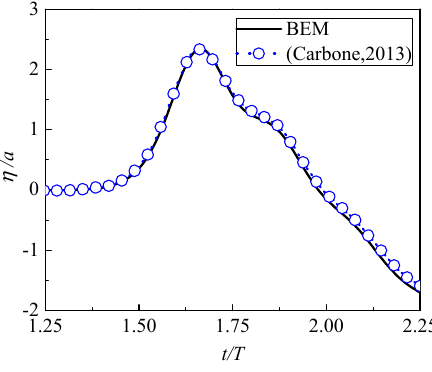
Figure 3. History of wave run-up along the vertical seawall for the single-crest wave train case.